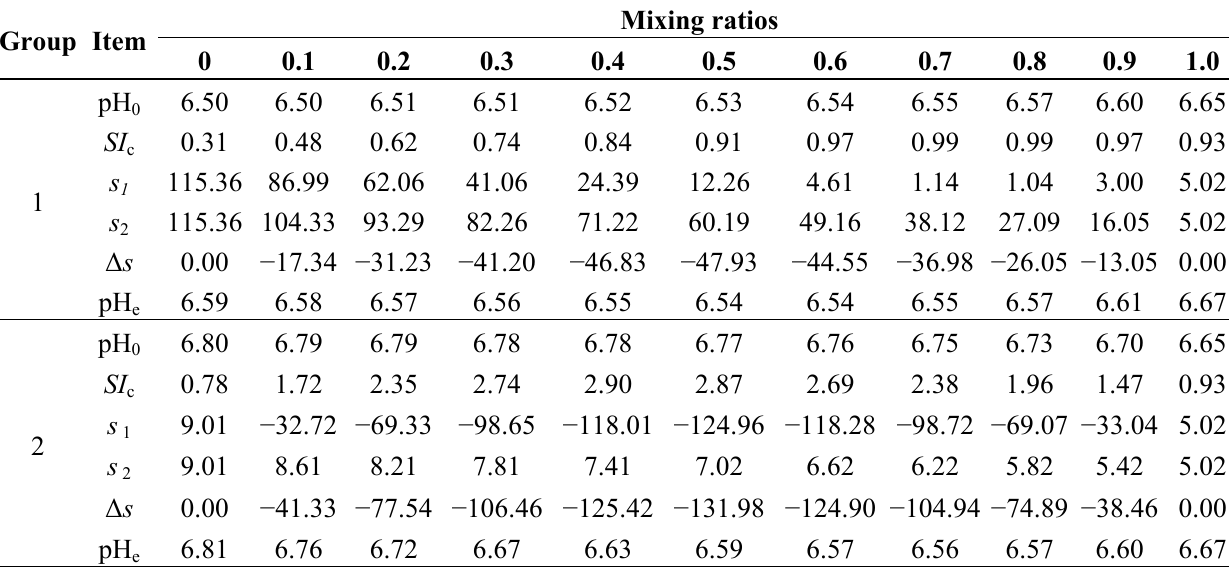
Table 3. Calculated results for mixed water from two unsaturated samples (group 1: water samples 1 and 2; group 2: water samples 1 and